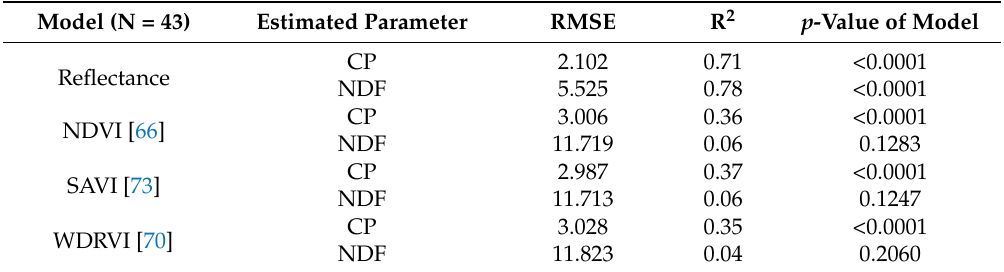
Table 5. Partial least-squares (PLS) regression results for reflectance-based (the best selected) and vegetation indices-based models.